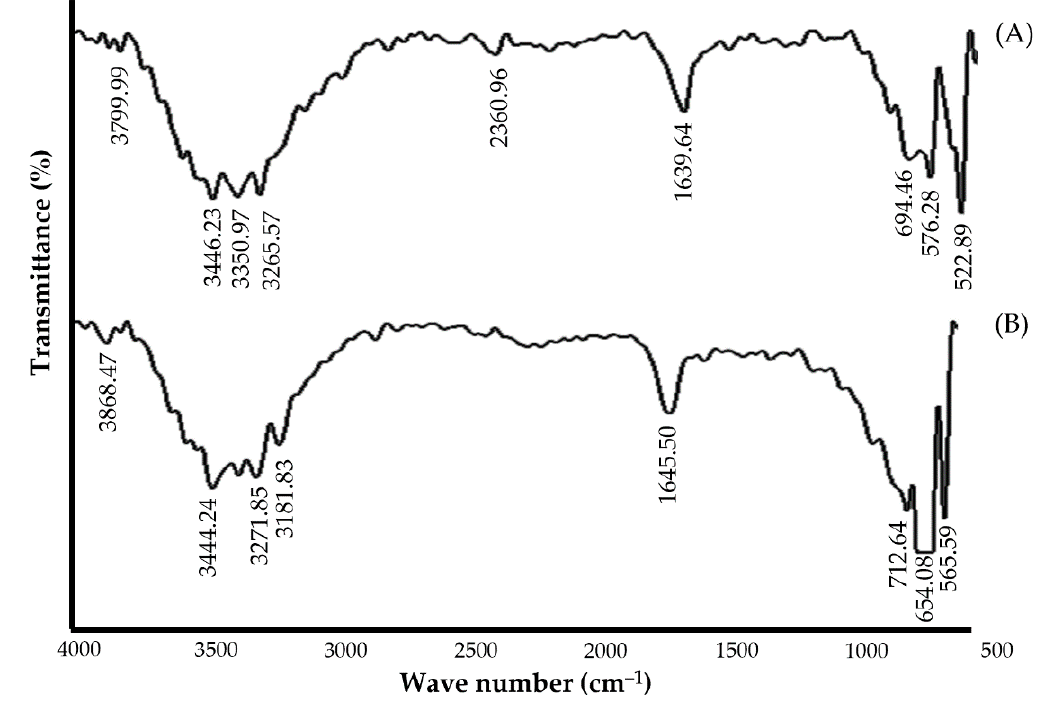
Figure 5. FT-IR spectra of ( A ) Guggul extract, and ( B ) Silver nanoparticles.